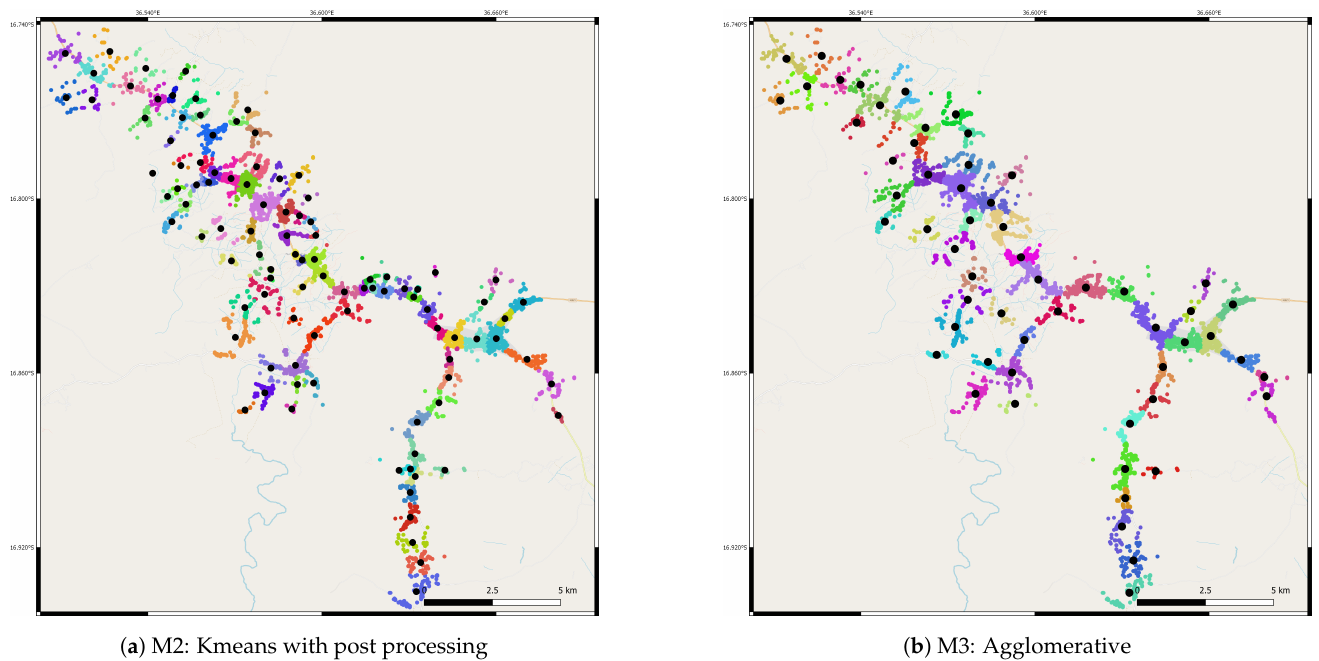
Figure 6. Results of clustering procedures in Namanjavira.